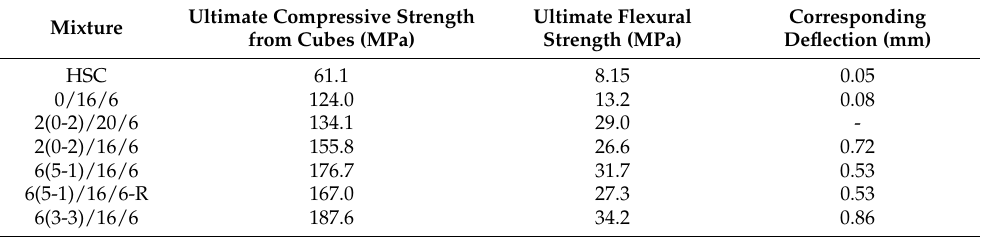
Figure 10. Direct tensile stress–strain curves from beams and bone-shaped specimens. Results from indirect (three-point bending) tensile tests are shown in Table 2 below. Results are similar to direct tensile test results. HSC and mixture 0/16/6 had the lowest indirect tensile strength and deflection and exhibited sudden failure. UHPFC mixture achieved 13.2 MPa which is 62% greater than the tensile strength of HSC mixture. With the addition of 2% by volume of steel fibers and lower water to binder ratio of 0.16, the ultimate flexural tensile strength raised to 26.6 MPa (102% higher). The increase of steel fibers from 2% to 6% by volume caused an increase of the indirect tensile strength. Mixture 6(3-3)/16/6 achieved the highest ultimate indirect tensile strength and corresponding deflection. Mixtures with 6% (short to long steel fibers ratio 5:1) by volume showed the highest variability in the results. In Table 2, the compressive strength values from cube testing are also presented. Table 2. Ultimate compressive strength from cubes and indirect tensile strength with the correspond- ing